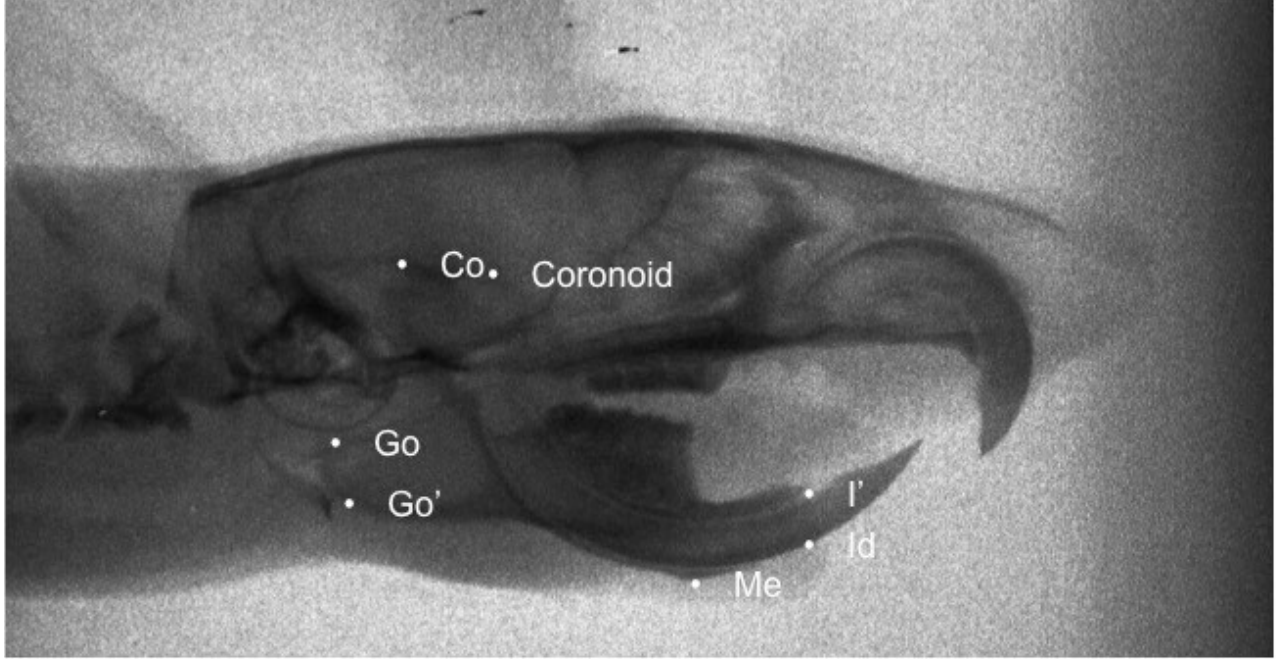
Figure 1. Traced Xray for linear mesasurement. The landmarks we used are the most posterior- superior point on the mandibular condyle (Co), the most posterior point of the angular process of the mandible (Go), the point on the most inferior contour of the angular process of the mandible (Go’), the most posterosuperior point of condylar process (Coronoid), the most inferior and anterior point of the lower border of the mandible (Me), the most inferior and anterior point on the alveolar process of the mandible (Id) and the most anterior edge of the alveolar bone on the convexity of the lower incisor (I’).